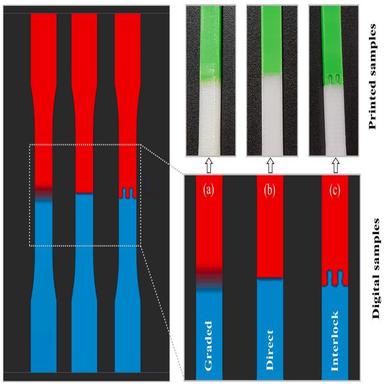
Tensile specimens with interface patterns (a) Continuous gradient transition. (b) direct transition, (c) interlock transition.